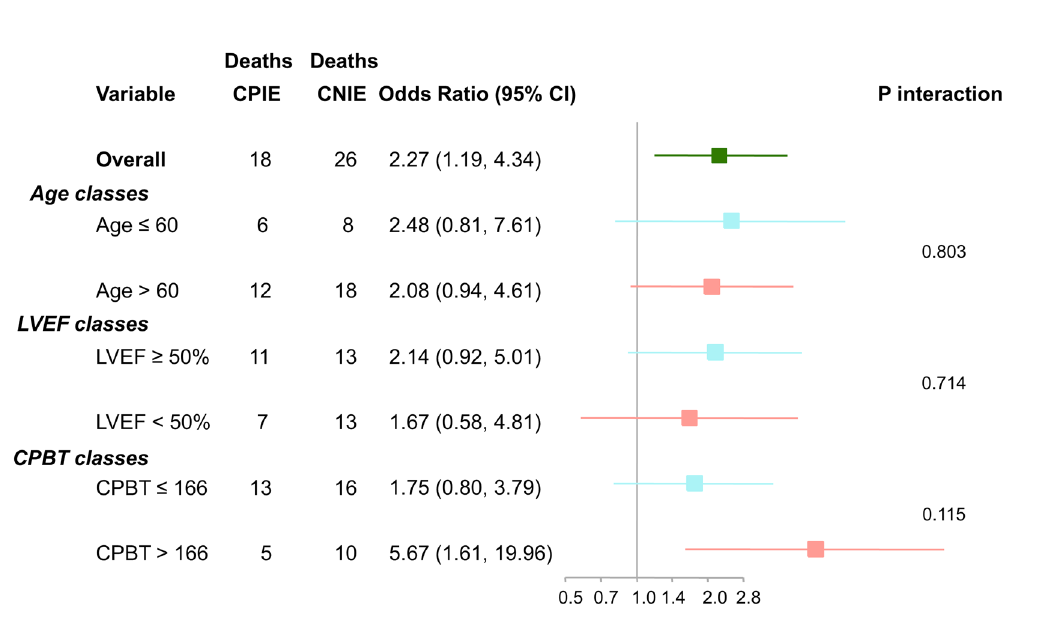
Figure 1: Subgroup analysis for in - hospital mortality with variables ’